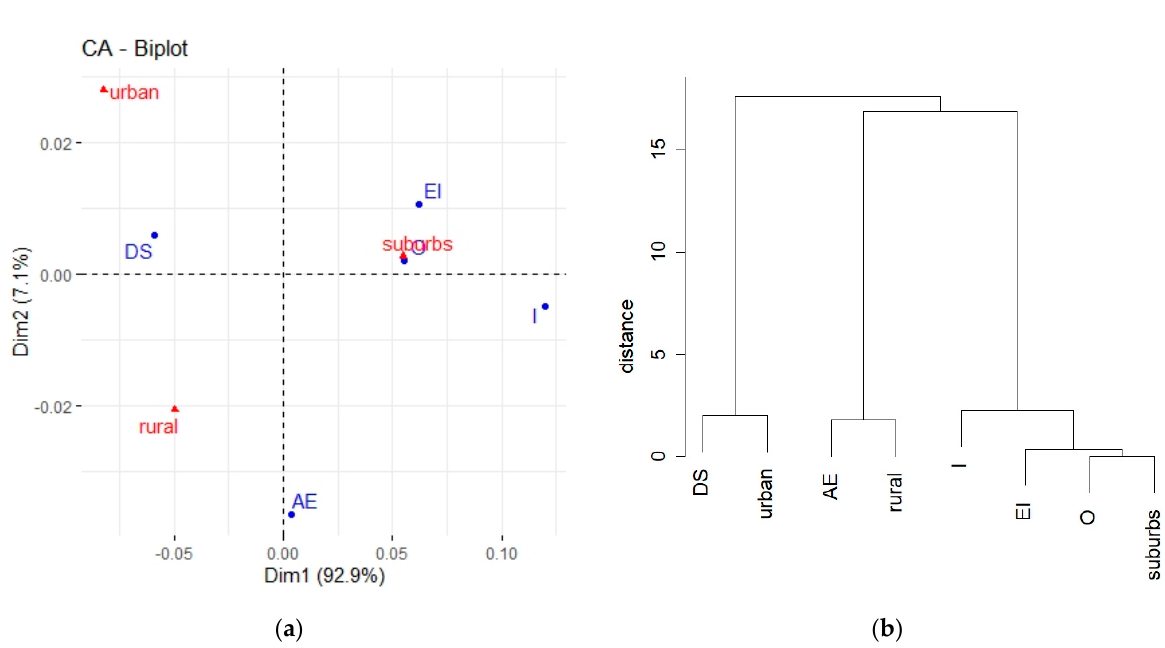
Figure 9. Correspondence map ( a ) and an auxiliary dendrogram ( b ) showing the dependence of each behavioural type of energy consumer on their place of